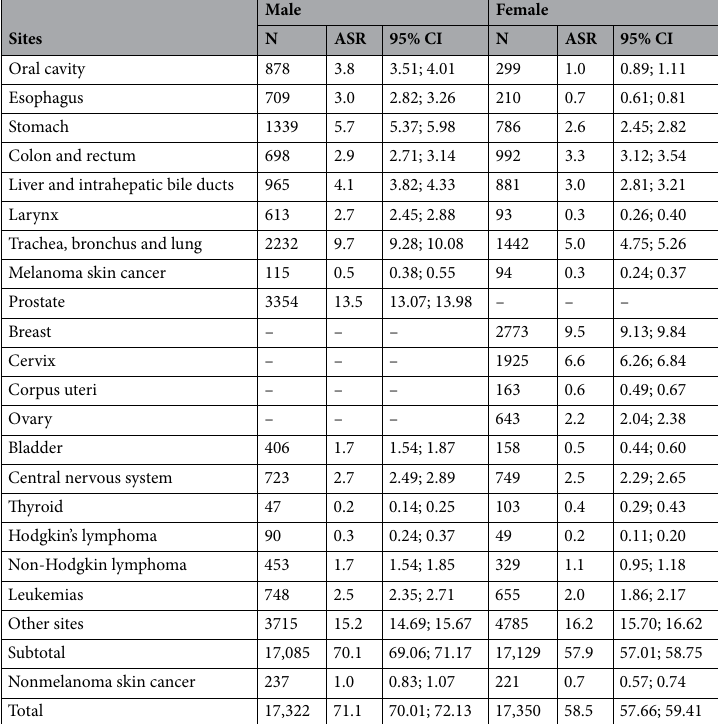
versus 57.9) and in the last five years (97.2 versus 72.0). The average mortality ASRs from 2014 to 2018 were similar to those observed for the group of medium HDI countries in GLOBOCAN 2018 1 . As expected for chronic diseases, the 65+ age group showed the greatest increase in the mortality trend, most pronouncedly among men. Interestingly, the male age group 20–44 years old presented a slight increasing trend